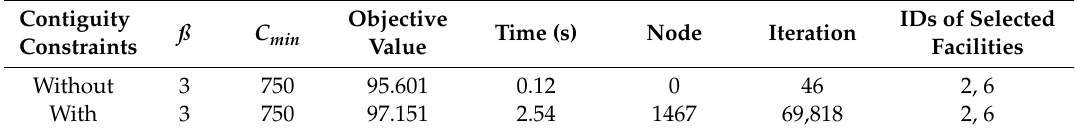
Table 1. Computational results for the small dataset ( n = 13, p = 3).